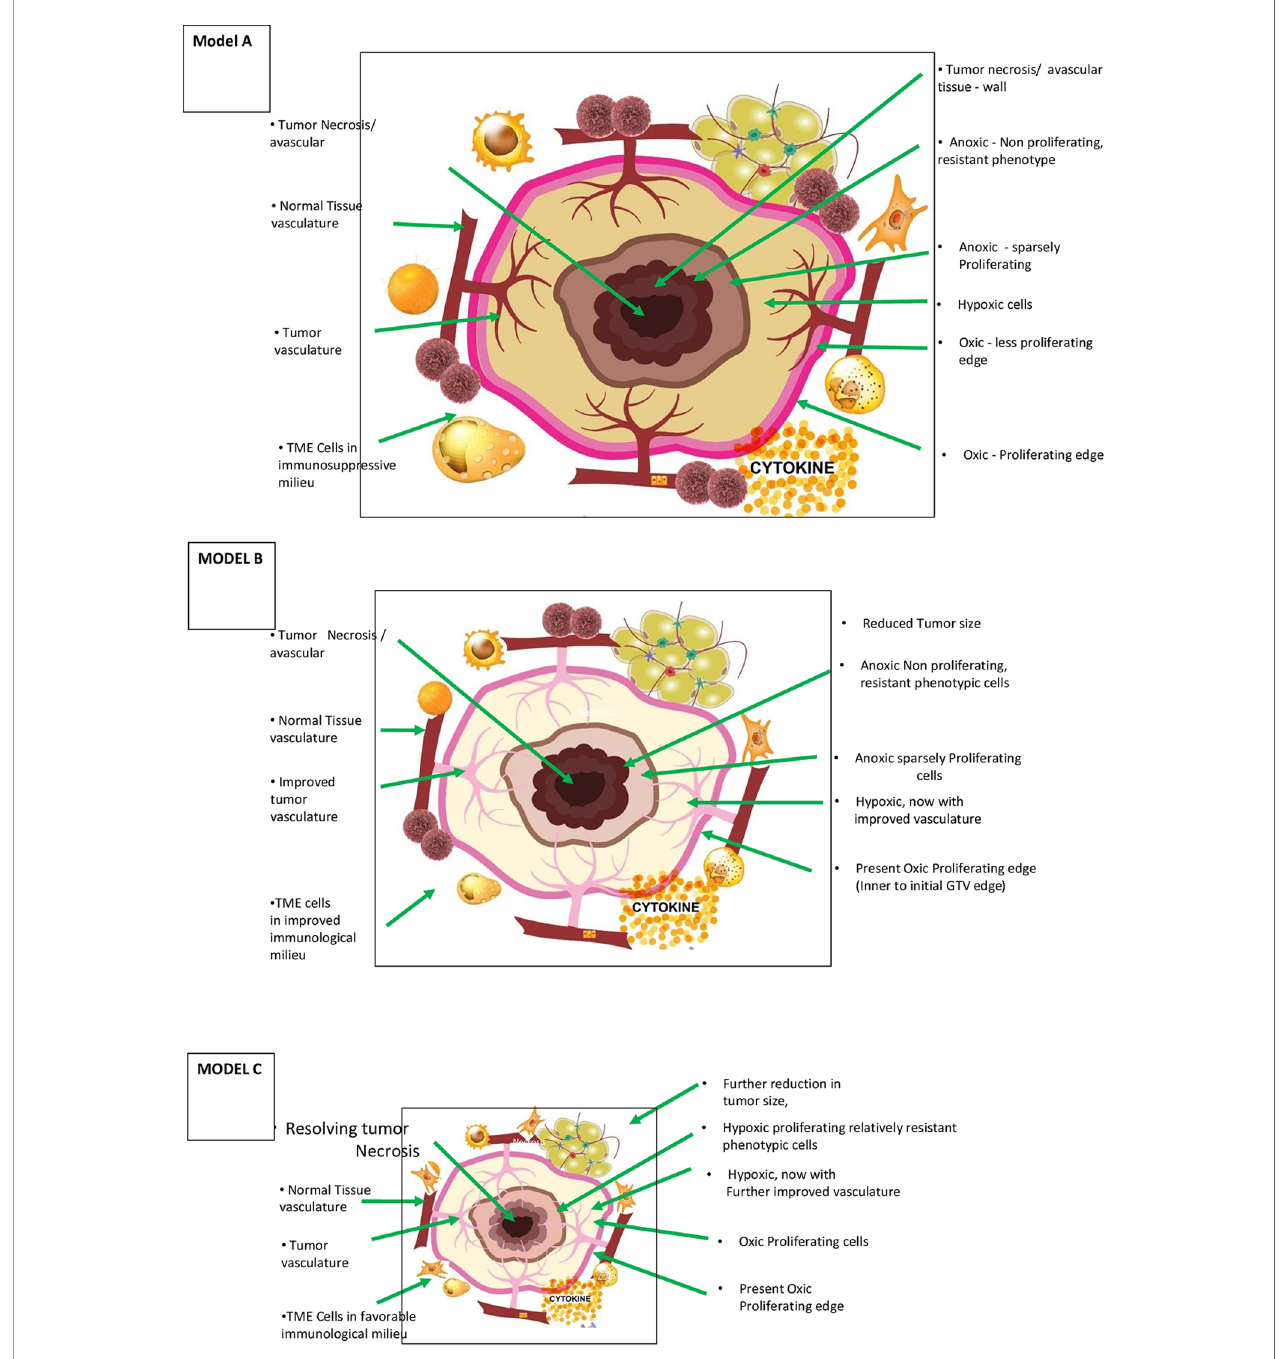
FIGURE 1 | Theoretical Model A – Morphological and patho-physiological aspects of vascular-immuno-phenotypic (VIP) tumour model for SBRT and vascular sparing dose painting technique in a range of 5 – 10 Gy per fraction) ( literature evidence available – see text ) (7, 23). This is a simpli fi ed diagrammatic representation, and anoxic and necrotic volumes can be located eccentrically or irregularly distributed through the tumor mass. Varied, mildly hypoxic to anoxic cells are considered one of the major reasons for radiation/SBRT failure requiring stratagic dose scheduling and combinatorial therapies. Theoretical Model B – Morphological and patho- physiological aspects of VIP tumour model during accelerated repopulation from day 21 to 30 of start of treatment concomitant SBRT boost with or without dose painting is to be validated. Improved vasculature, decreased interstitial pressure are the other major changes during this phase. Theoretical Model C – Morphological, patho-physiological aspects of VIP Tumor model after completion of prescribed course of chemo/targeted/immuno-therapy or 3 months after radiotherapy, residual/ oligo-persistance/early recurrent or oligo-progression. When present, this is the period of least tumour burden and maximum normalization with appropriate dose per fractions during initial session and when not suitable for salvage surgery, “ delayed ” SBRT boost with or without dose painting is to be validated.